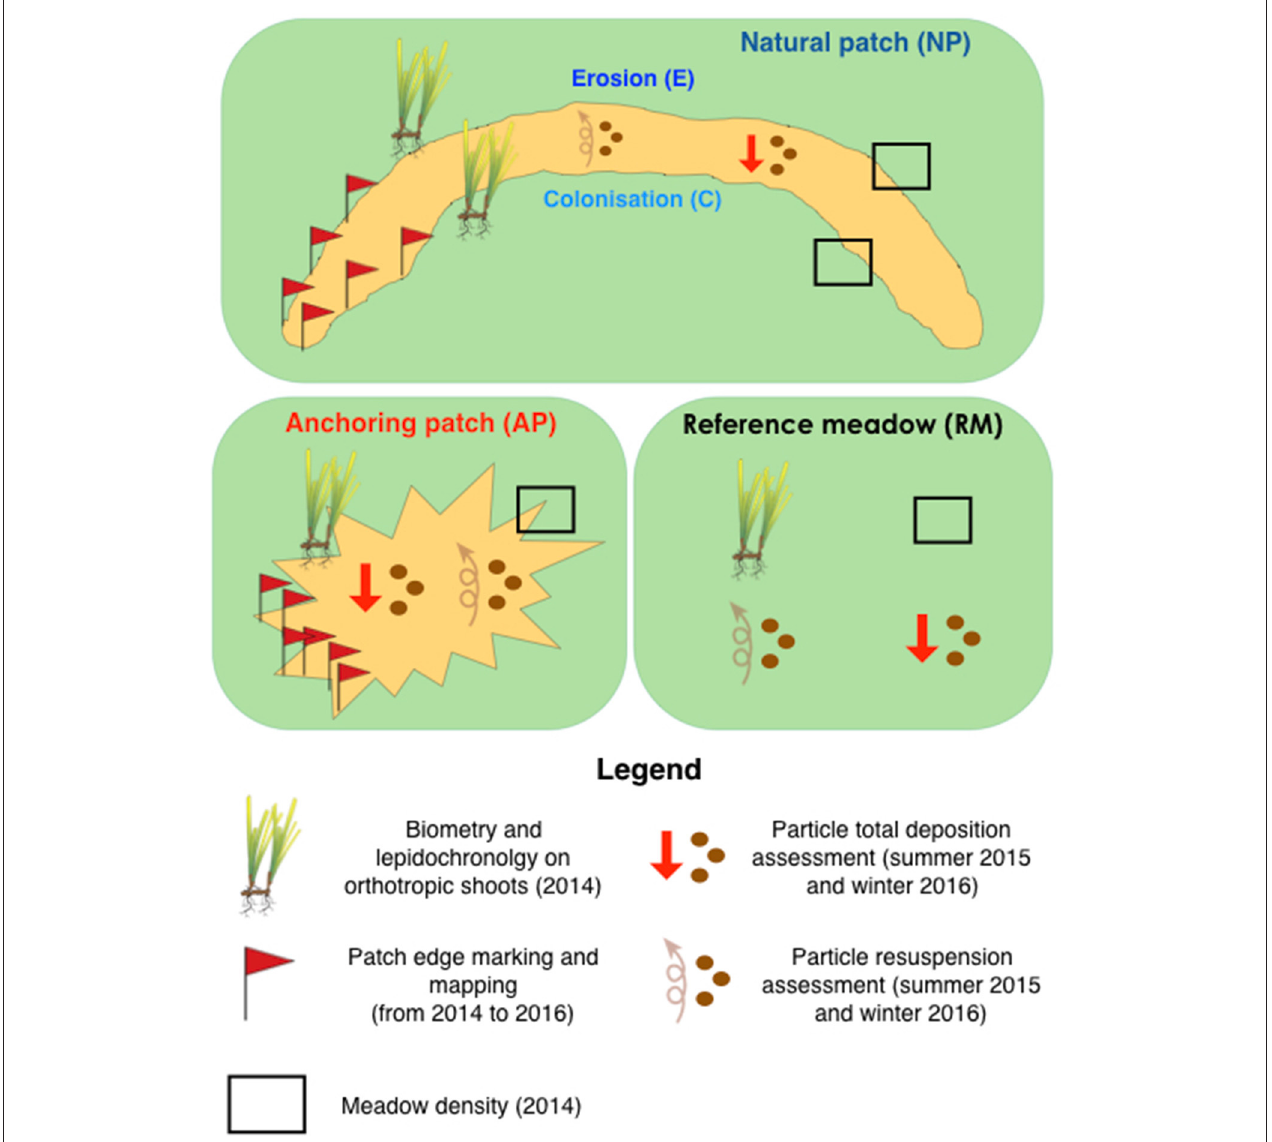
FIGURE 3 | Sampling design encompassing lepidochronology, fine scale mapping, and biometry of orthotropic rhizomes, particle total deposition, and resuspension in natural and anchoring patches as well as in a continuous reference P. oceanica meadow.